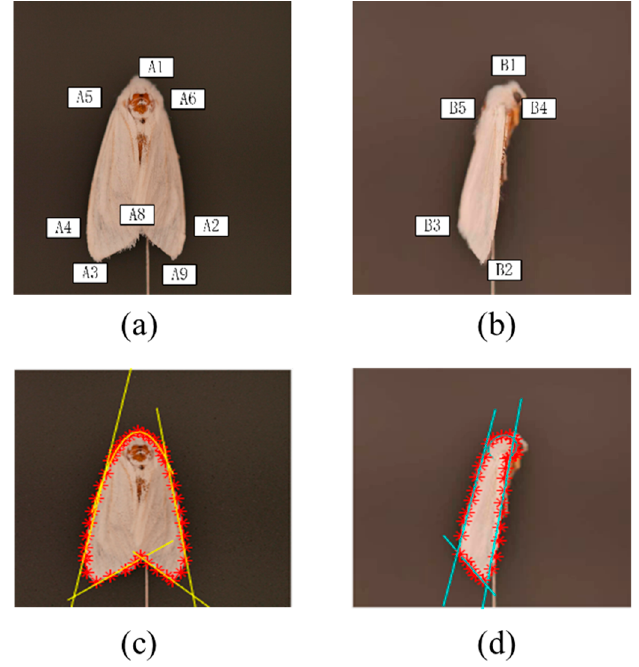
Figure 8. Fitting results of edges with wings angle less than 180 ◦ of H. cunea : ( a ) split points for the back view image are selected; ( b ) split points for the right view image are selected; ( c ) edge fitting result of the back view image; and ( d ) edge fitting result of the right view image. In the second case. with the wings of H. cunea unfolded, the angle of the wings was more than 180 ◦ , and there was no triangle contour from the dorsal view image. The right and left view images were obtained when the H. cunea rotated 90 ◦ , and the approximate triangular wings were clearly visible. The outline of the humeral angle point was calculated based on the above methods, and key points were approximately positioned after fitting right and left view image edge points. The anal angle point was the lowest point in the wing profile, that is, the point with the lowest y value. The apical corner of the right wing is the leftmost point of the contour points, that is, the lowest x value point. The apical corner of the left wing is the rightmost point of the contour points, that is, the point with the maximum x value. The apical corner of the left wing was the rightmost point of the contour points, that is, the point with the maximum x value. Figure 9 shows the left-wing humeral angle fitting schematic diagram and the right-wing humeral angle fitting con- traction.